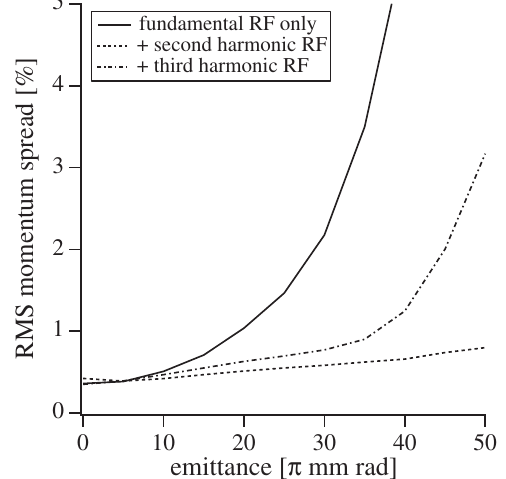
FIG. 6. Final momentum spread as a function of initial trans- verse emittance with and without higher harmonic